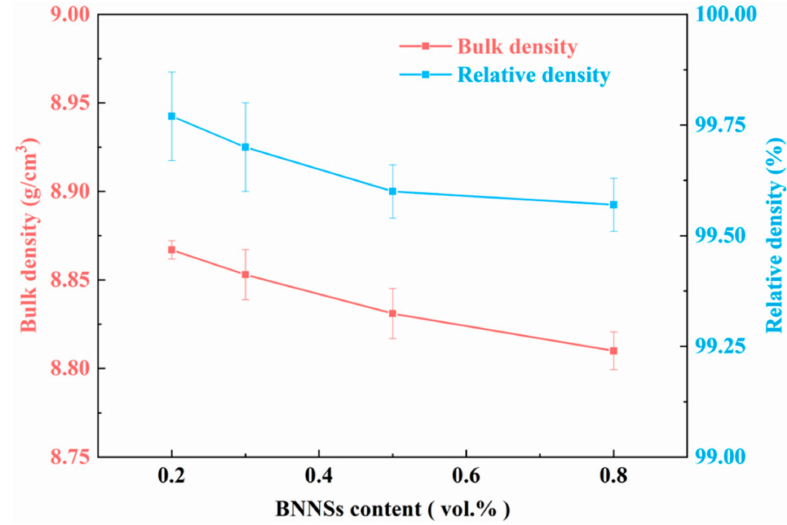
Figure 4. Bulk density and relative density: 0.2-CMC, 0.3-CMC, 0.5-CMC, 0.8-CMC.